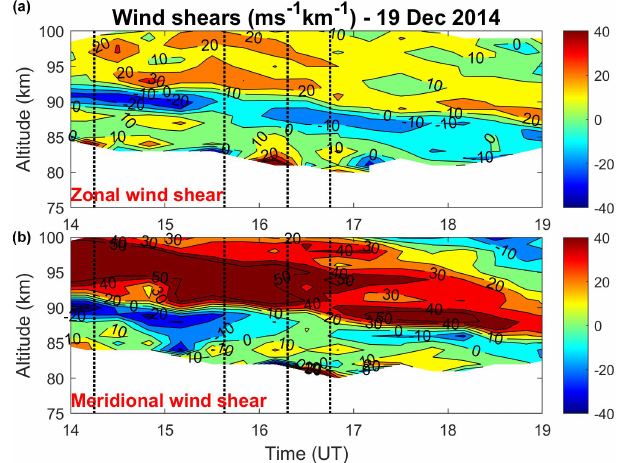
Figure 7. (a) Background temperature structure and (b) square of buoyancy frequency ( N 2 ). The dotted black lines indicate the esti- mated times of zenith passage of the fronts.